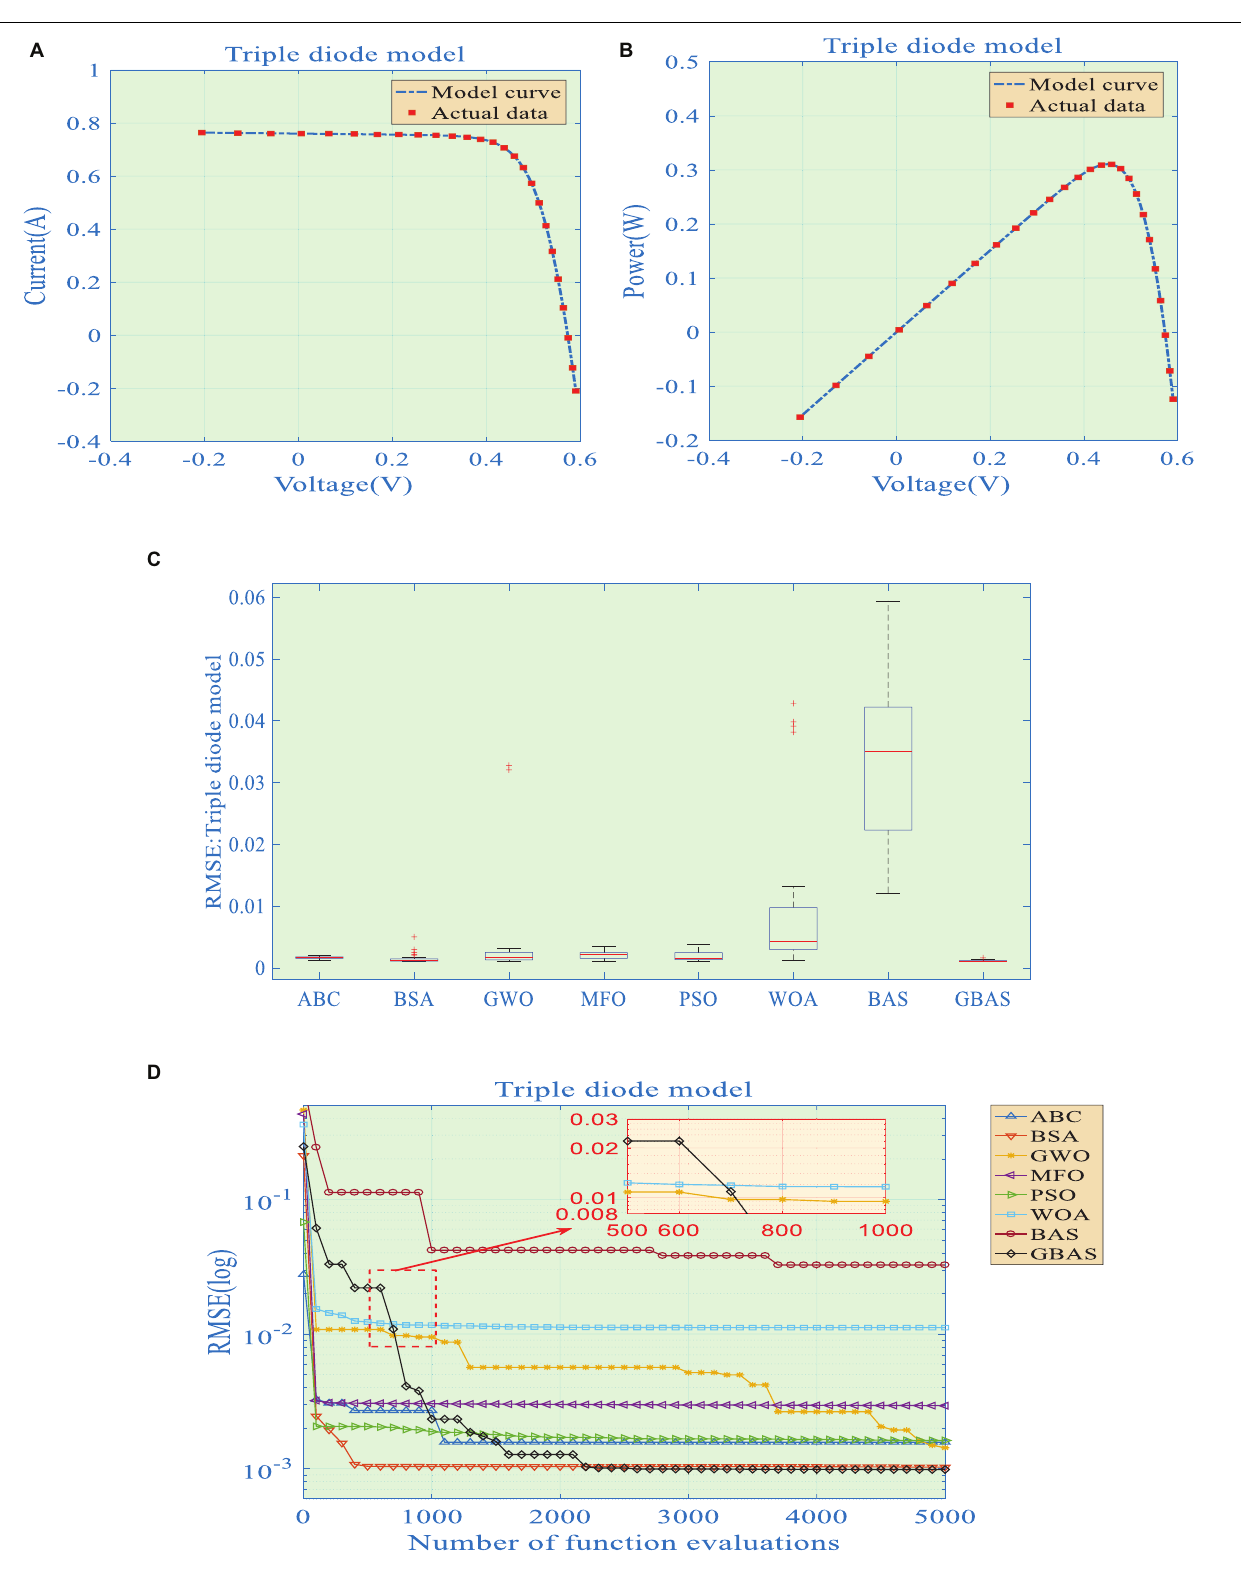
FIGURE 4 | Identification results obtained by grouped beetle antennae search (GBAS) algorithm for triple diode model (TDM): (A) I-V curve; (B) P-V curve; (C) boxplot of RMSE; (D) convergence graph.